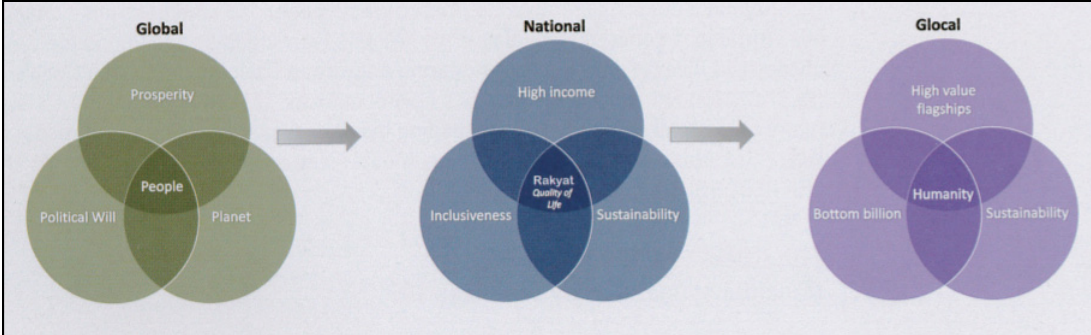
Figure 3. Sequence of Development of ESD Envisioned by USM. Source: ([29], p.